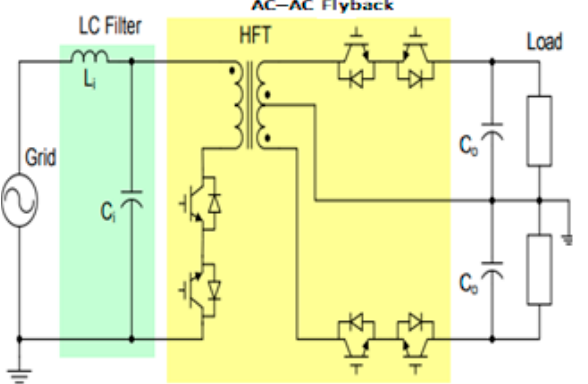
Figure 10. Single-stage SST based on an AC–AC Flyback converter [71]. Reprinted with permission from Ref. [71]. 2022, IEEE.